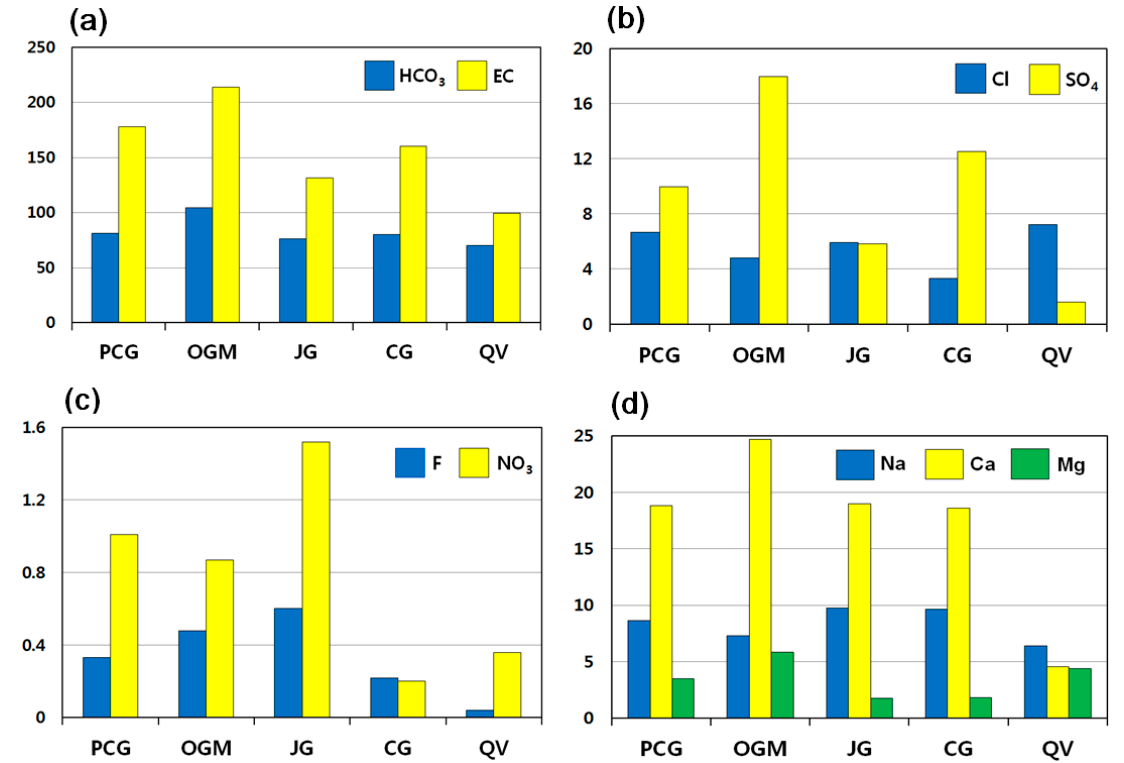
Figure 2. Mean concentrations of chemical components in groundwater related to geology. ( a ) HCO 3 and EC, ( b ) Cl and SO 4 , ( c ) F and NO 3 , and ( d ) Na, Ca, and Mg. PCG: Precambrian gneiss; OGM: Ogcheon metamorphic rocks; JG: Jurassic granite; CG: Cretaceous granite; QV: Quaternary Jeju Island volcanic rocks. EC as μ S/cm. Unit in mg/L unless otherwise noted.